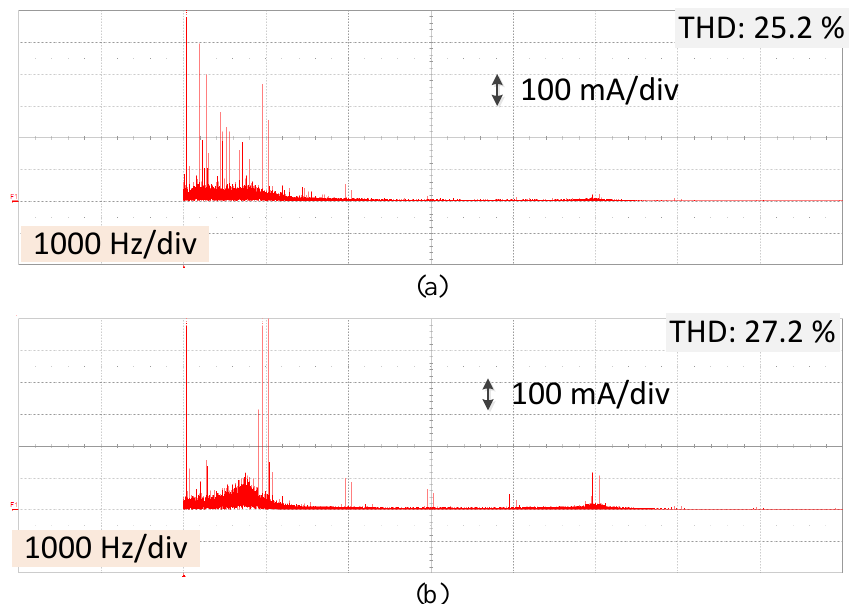
Figure 10. Experimental frequency spectra of A-phase motor current at 600 rpm. ( a ) MSPTC, ( b ) UFCS-PTC.